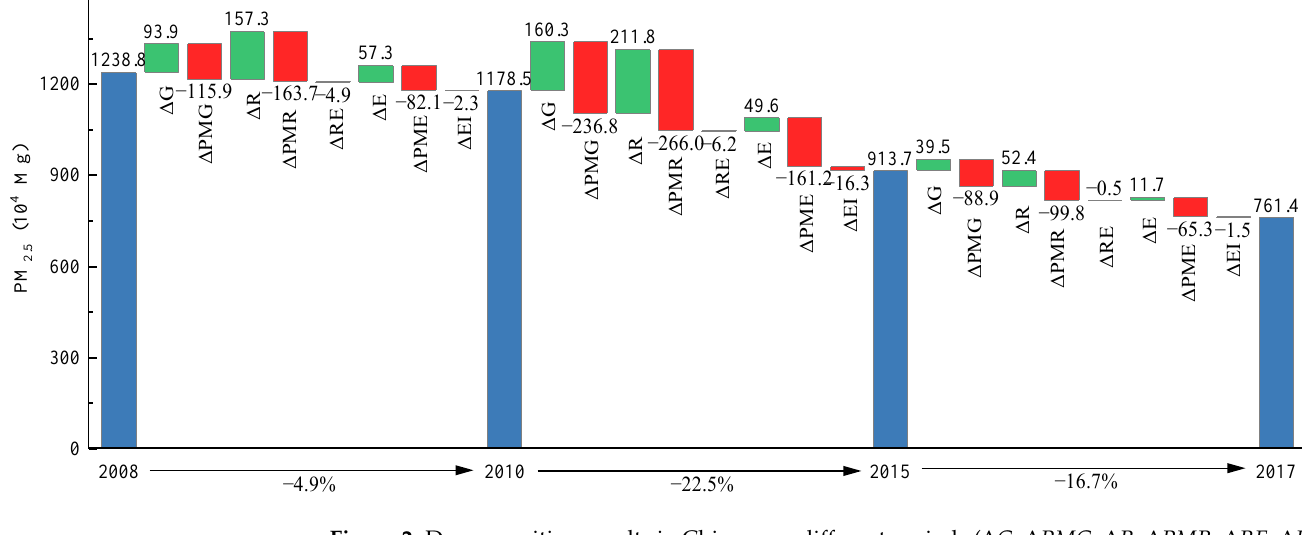
Figure 2. Decomposition results in China over different periods ( ∆ G , ∆ PMG , ∆ R , ∆ PMR , ∆ RE , ∆ E , ∆ PME and ∆ EI denote the effects of changes in GDP, emission intensity, innovation input scale, innovation input PM 2.5 intensity, innovation input efficiency, energy consumption scale, emission coefficient, and energy intensity on the changes in PM 2.5 emissions, respectively).